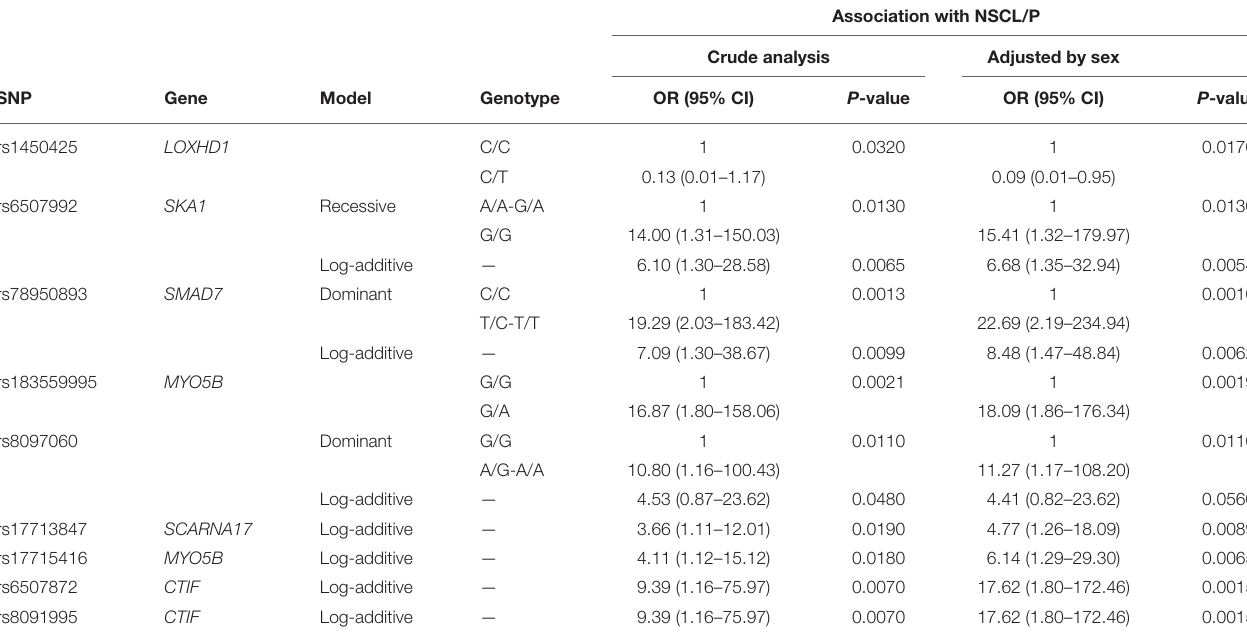
TABLE 5 | Results for the SNPs found significant using snpStats in the genotype-phenotype association analysis between SNPs vs. NSCL/P risk, represented in terms of odds ratios of mutant